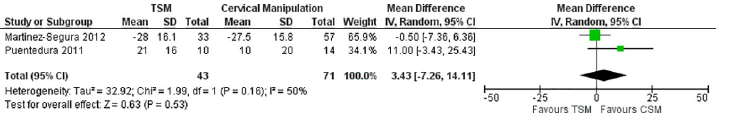
Fig 6. Meta-analysis of TSM versus cervical manipulation for pain without a distinction between immediate and short-term follow-up.